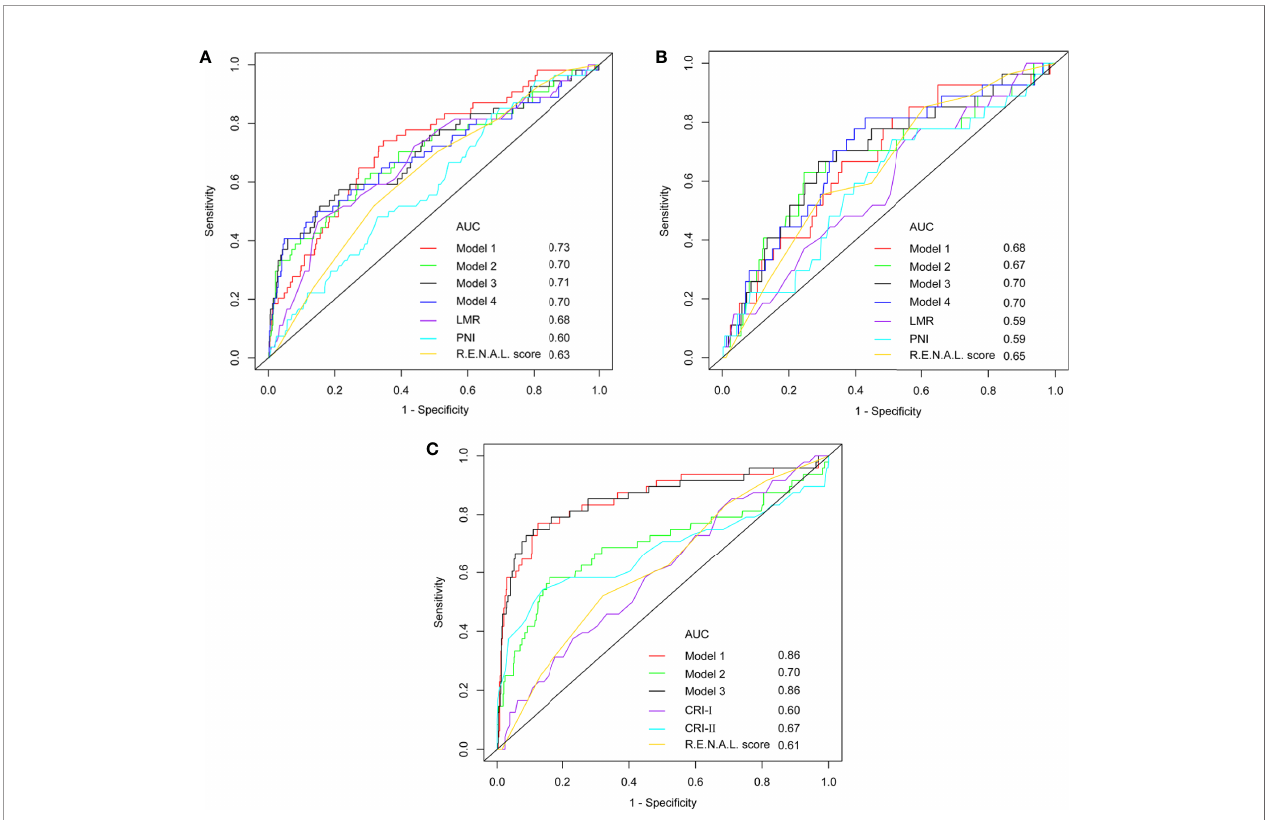
FIGURE 3 | The ROC curve analyses for models in training cohort (A) , validation cohort (B) and subpopulation (C)